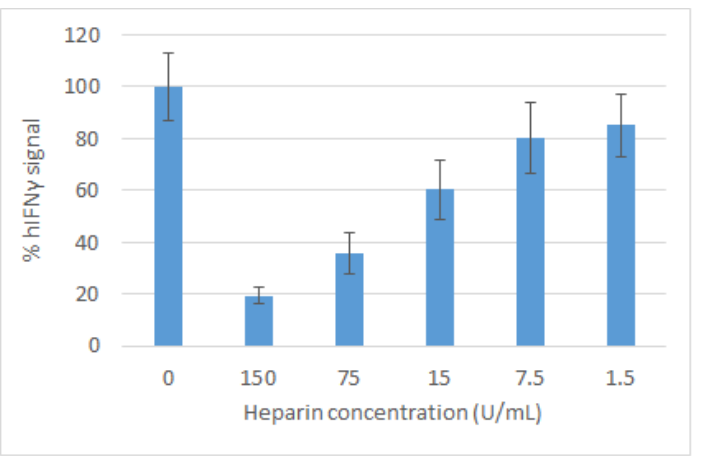
Figure 4. Inhibitory effect of LMWH on the production of IDO induced by 100 IU/mL recombinant IFN γ . After subtraction of the blank value, the absorbance obtained from cells treated with a mixture of IFN γ and LMWH is related to that obtained from cells treated with IFN γ only, taken as 100%. The bars represent the statistical errors.